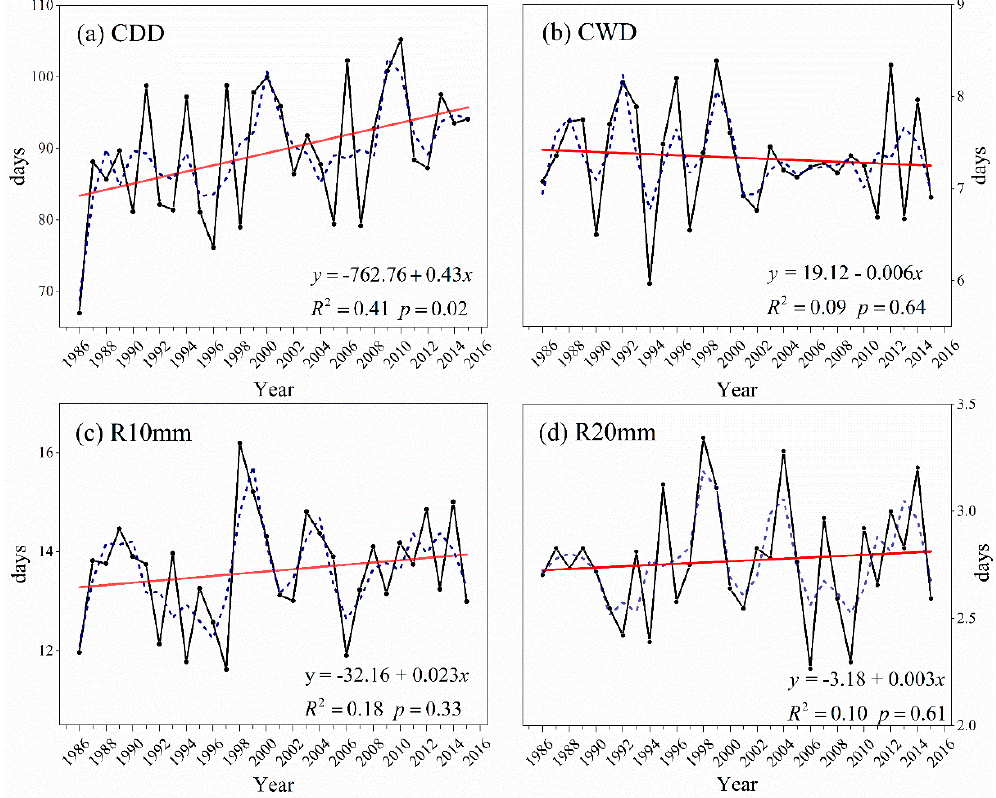
Figure 2. Interannual variation of precipitation days across the Tibetan Plateau from 1986–2015. Graphs represent ( a ) CDD, ( b ) CWD, ( c ) R10mm, and ( d ) R20mm. The black solid line is the interannual variation, the red solid line is the linear trend, and the blue dotted line is the five-year smoothing